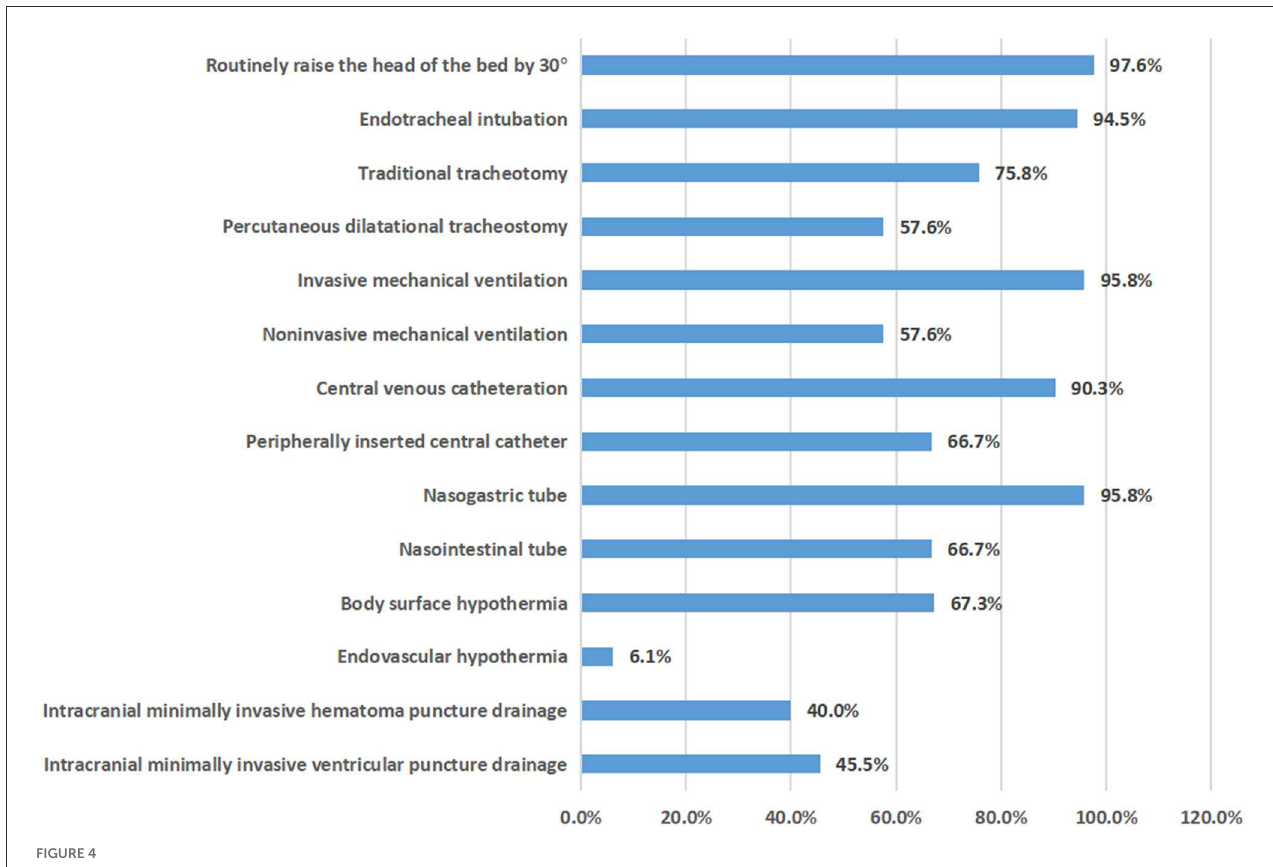
FIGURE4 Proportion of 165 NCCU treatment technologies in